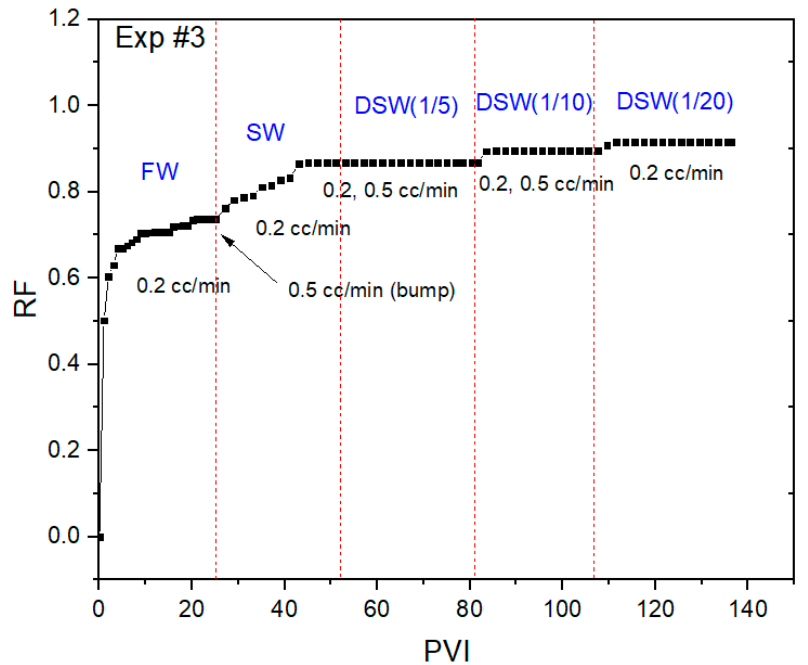
Figure 6. Oil recovery of experiment 3 using crude oil as the oil phase and Stevens Klint as the rock material. The flow rate starts with 0.2 mL/min and increased to 0.6 and then to 0.9 mL/min before changing each brine.